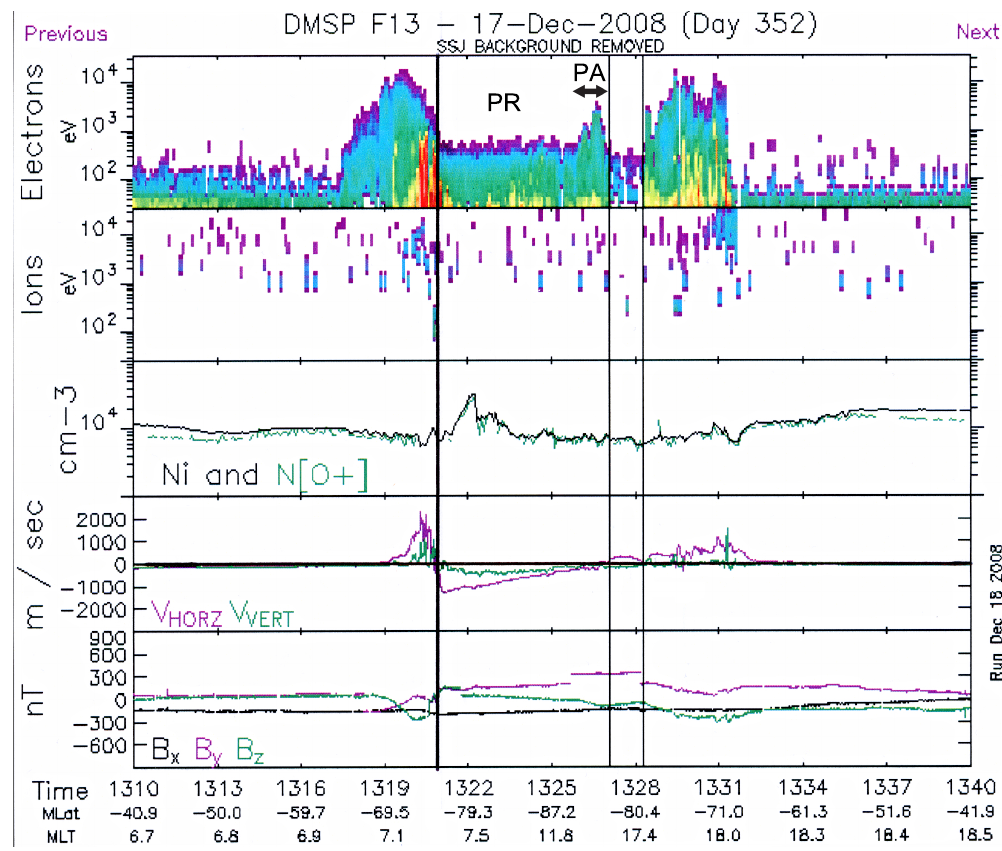
Fig. 7. Particle precipitation, ion drift, and magnetic deflections obtained by spacecraft DMSP F 13 during a Southern Hemisphere pass during 13:10–13:40UT on 17 December 2008. Panels from top to bottom show electron precipitation flux, ion precipitation flux, ion densities, cross track ion drifts, and magnetic deflection components B x , B y , and B z . Polar rain (PR), polar arcs (PA) and dropout of polar rain on the dusk side of the arcs have been